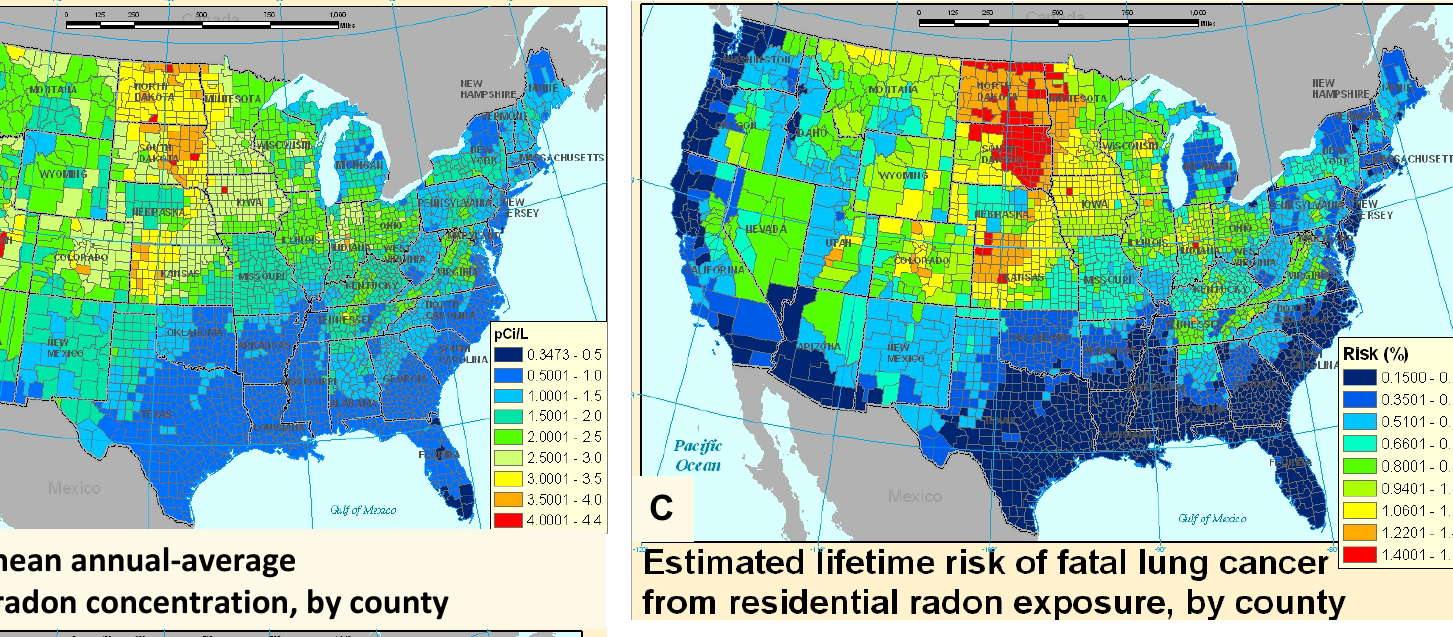
* Note that county-average risks include significant heterogeneity, and this figure cannot be used to identify individual homes as not needing to measure radon